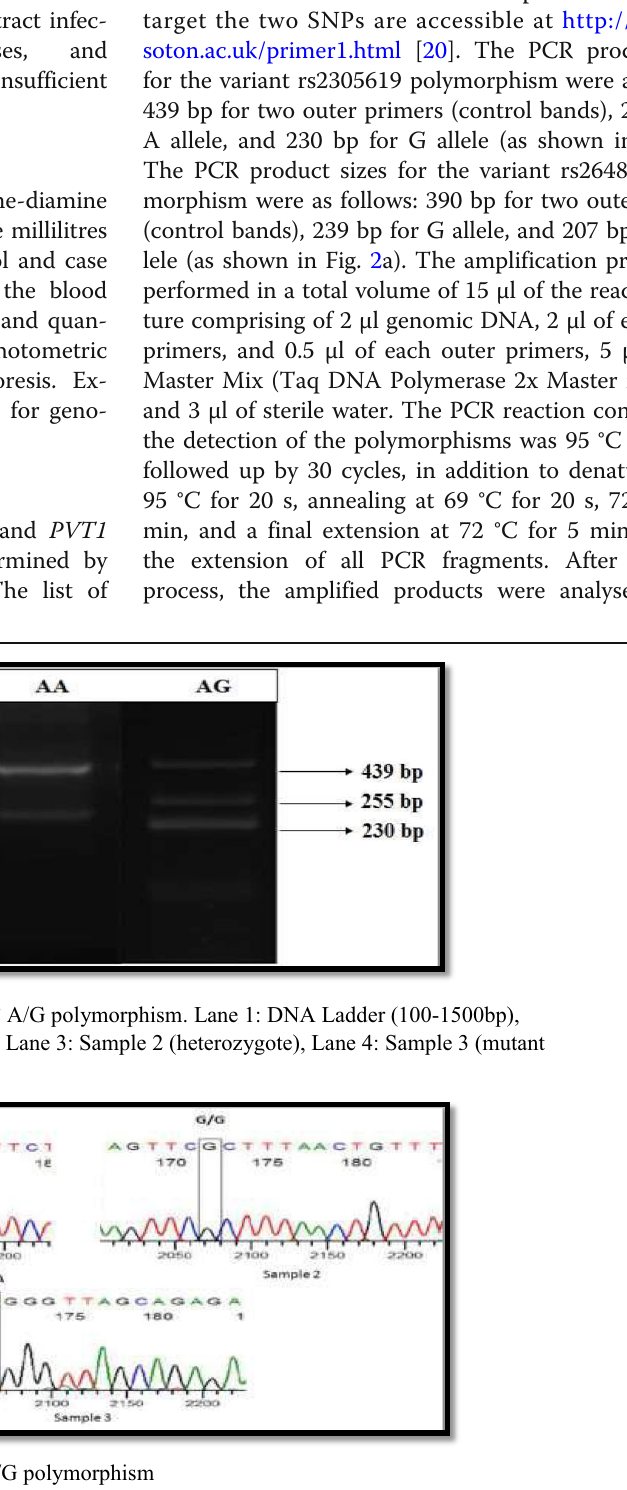
Fig. 1 a Gel picture representing PTX3 A/G polymorphism. Lane 1, DNA ladder (100 – 1500 bp); lane 2, sample 1 (heterozygote); lane 3, sample 2 (heterozygote); and lane 4, sample 3 (mutant homozygote). b Sequencing results of PTX3 A/G